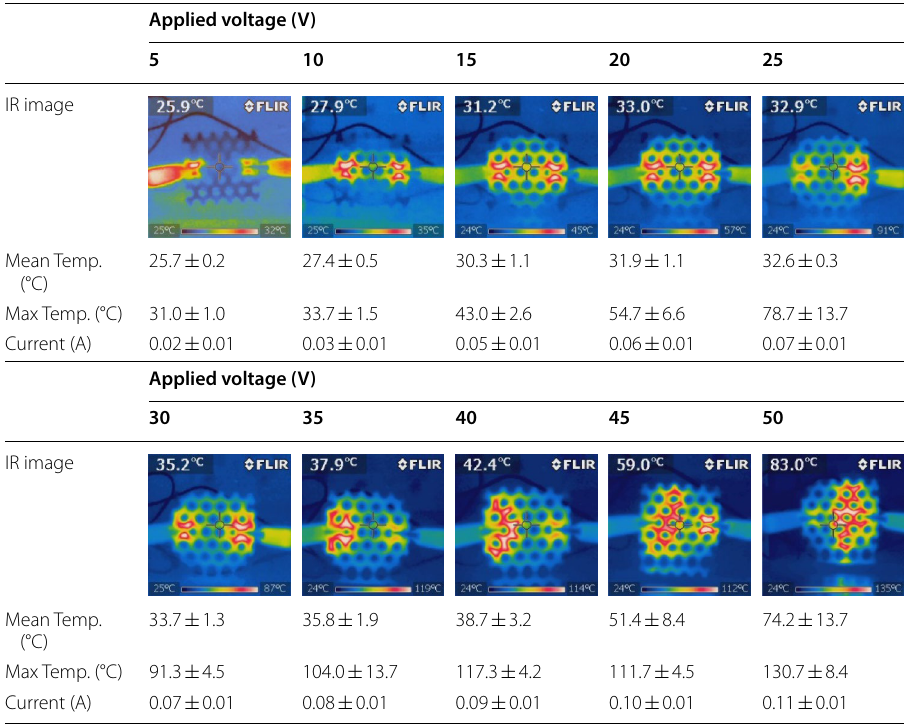
Table 8 IR images of CD carbon black/PLA 3D printed honeycomb